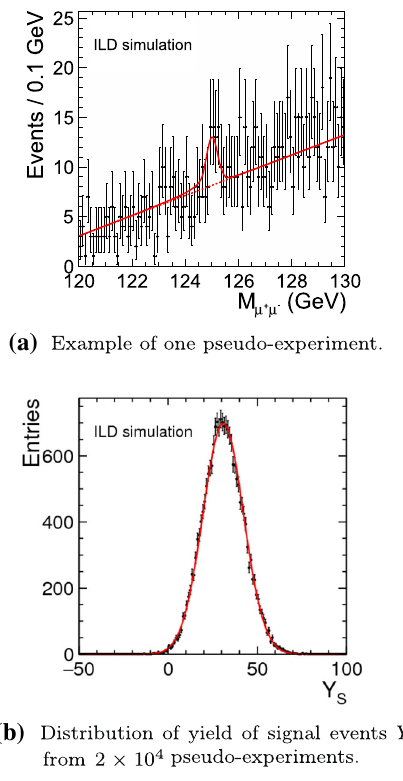
Fig. 8 Signal strength extraction in the nnH500-L channel. a Example outcome of one pseudo-experiment, with the pseudo-data shown as black points with error bars, while the solid red curve shows the result of an unbinned fit of f ≡ Y S f S + Y B f B to the pseudo-data. The dashed red line shows its background component Y B f B . b The distribution of theyieldofsignalevents Y S obtainedfrom2 × 10 4 pseudo-experiments, fitted with a Gaussian function. The mean value of the distribution is Y S = 30 . 9 with a width of 11.4 events, both obtained from the fitted Gaussian